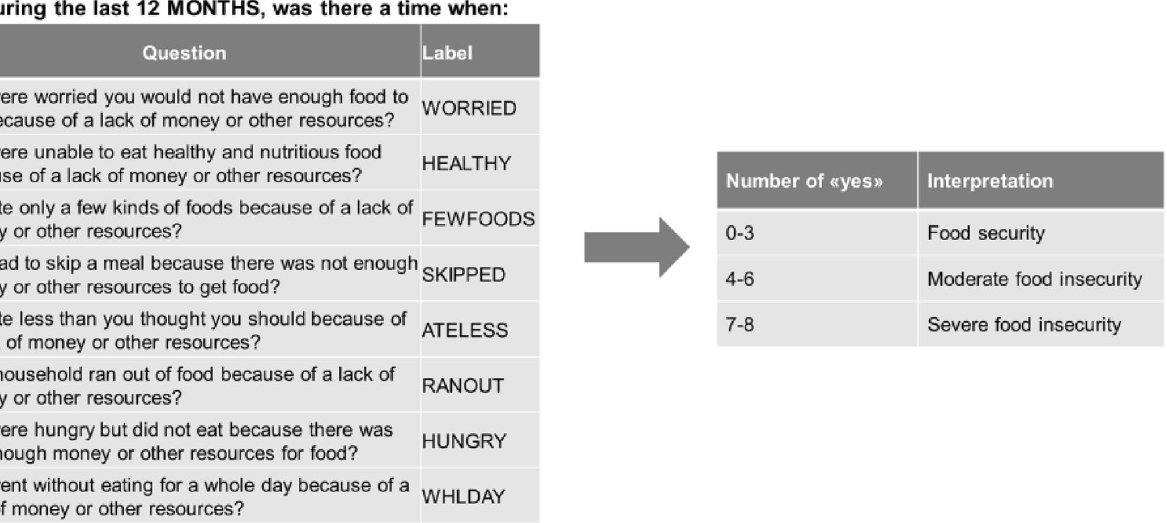
Figure 1. Food Insecurity Experience Scale (FIES): description and